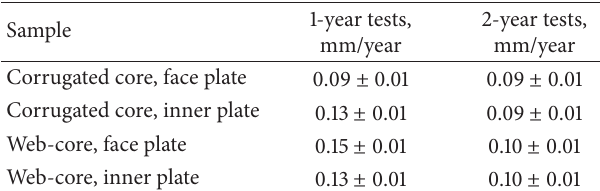
Table 5: Corrosion rates of unprotected samples after 1 and 2